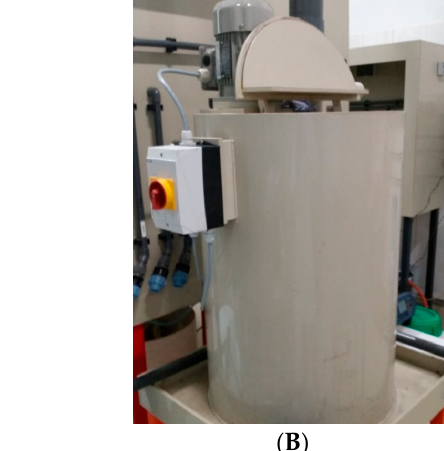
Figure 3. ( A ) Overview phase map of initial ore bearing vein; ( B ) Detailed view of different examples for hydraulic brecciation of sphalerite and pyrite. Fractures has been healed by quartz precipitation; ( C ) Detailed view of box in ( A ) with highlighted examples of idiomorphic textures at grain boundaries of quartz (pink) against an agglomerate of ore minerals.